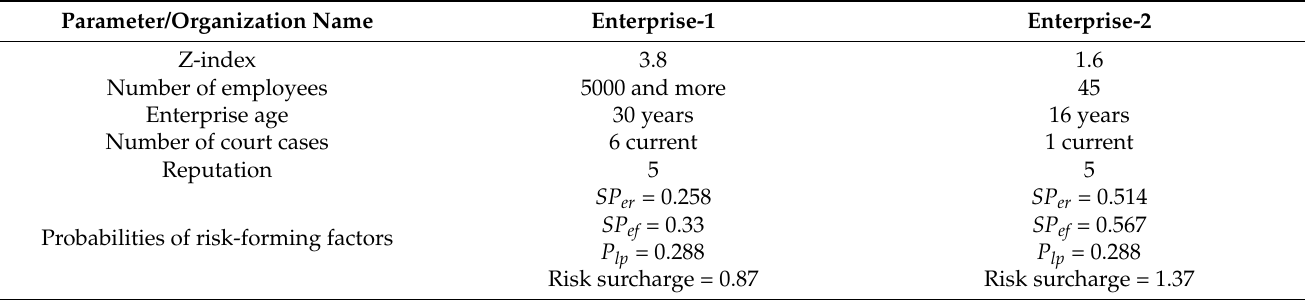
Table 6. Characteristics of Tenant